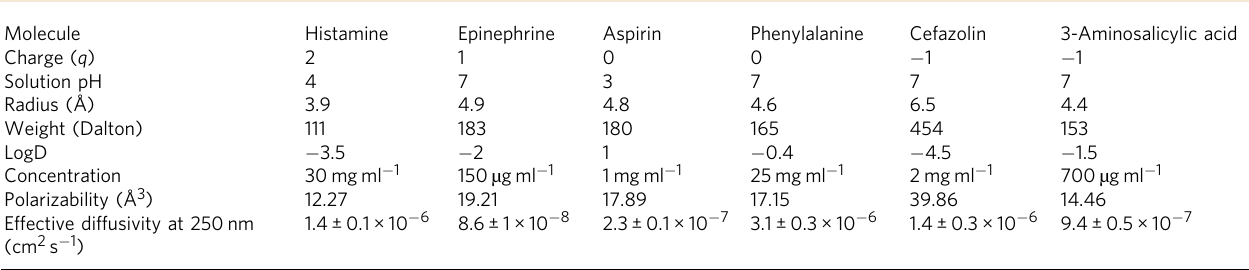
Table 1 Molecular properties of analytes tested Molecule